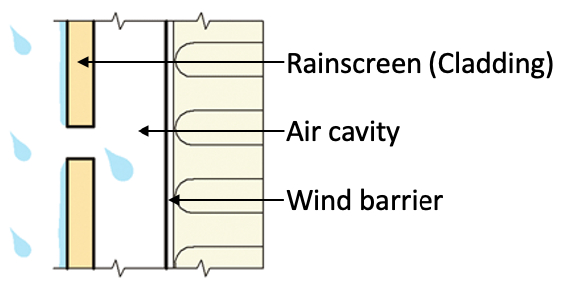
Figure 1. Principle of two-stage weatherproofing for an exterior wall with façade panels. The principle is not used for the horizontal open joint. Figure adapted from